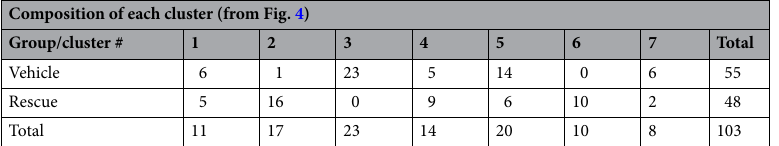
Composition of each cluster (from Fig.